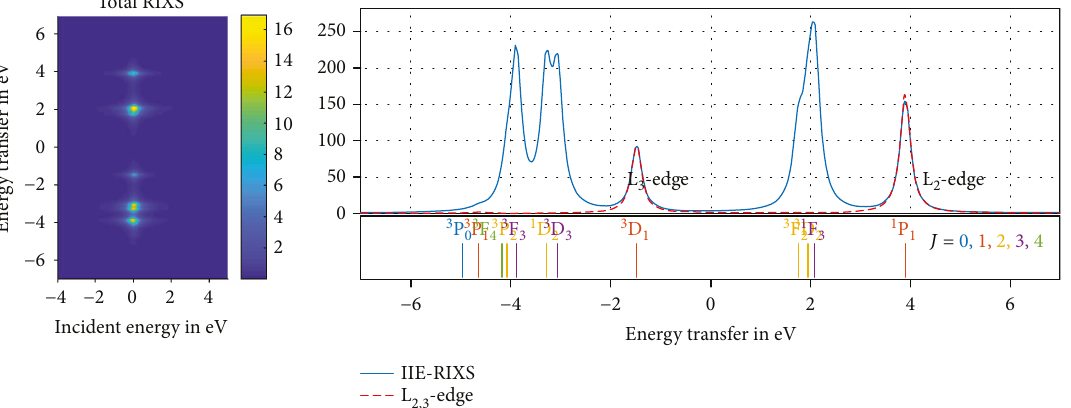
Figure 10: Calculated 1s2p RIXS map with 2p XES projection and the 2p XAS (L